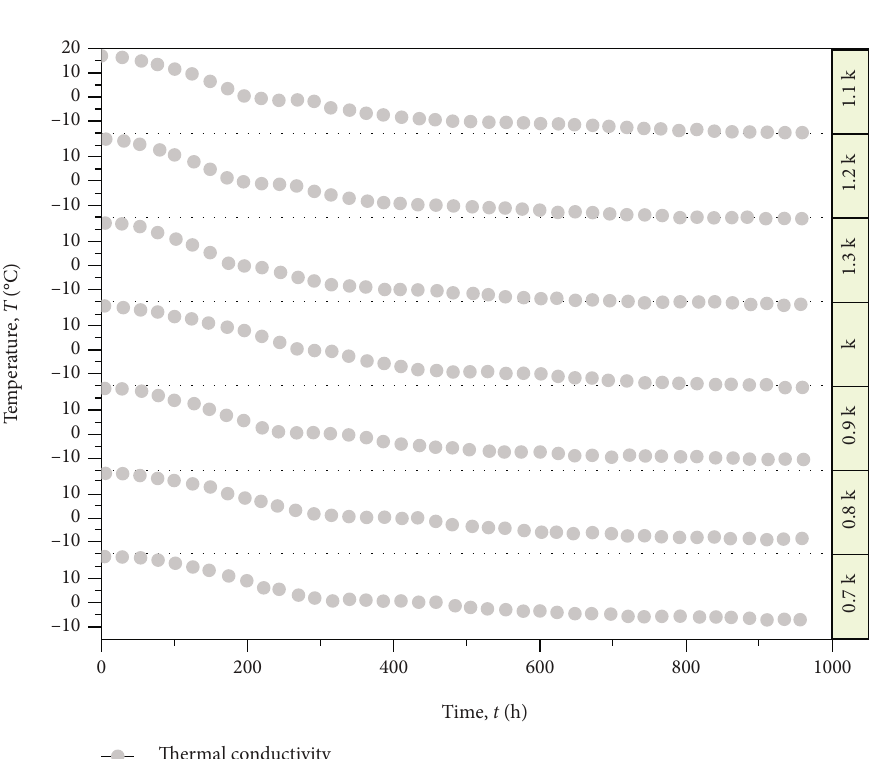
Figure 8: E ff ect of thermal conductivity on temperature fi eld